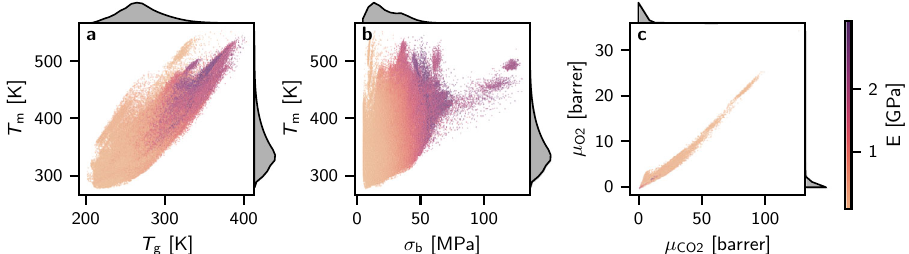
, μ , and E in the panels a – c stand for melting temperature, glass O 2 CO 2